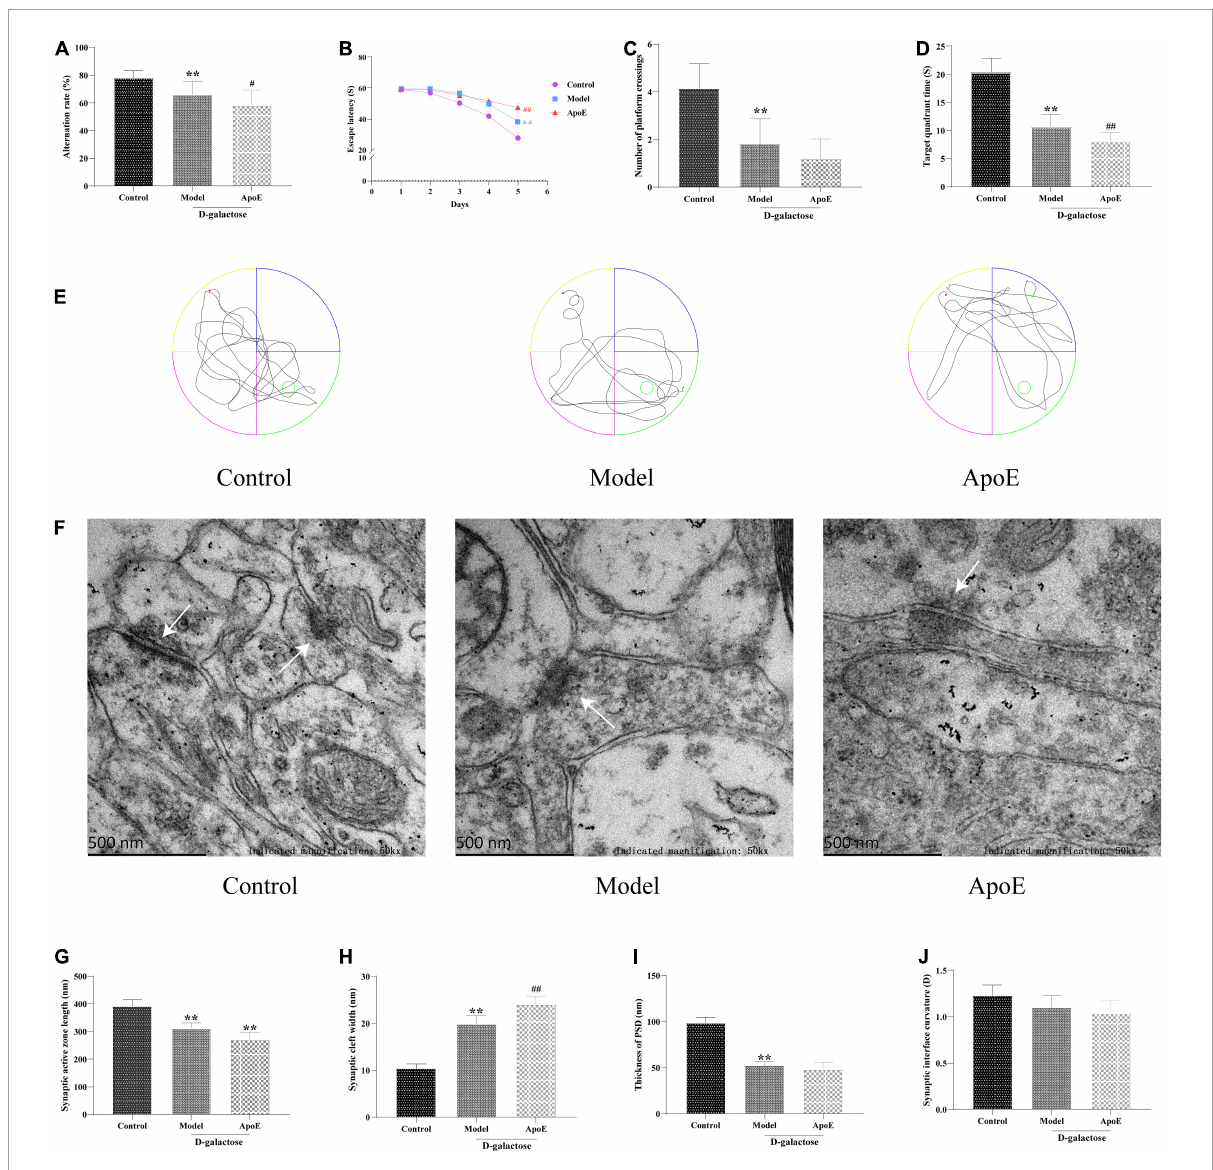
FIGURE2 Effects of ApoE on cognitive function and hippocampal synaptic ultrastructure in aging mice. (A) Y-maze test, n = 20. (B) Navigation test, n = 20. (C) Platform crossing, n = 20. (D) Target quadrant time, n = 20. (E) MWM representative figures. (F) Ultrastructure of hippocampal synapses. (G) Synaptic active zone length, n = 4 (Five synapses were randomly selected from each mouse). (H) Synaptic cleft width, n = 4 (Five synapses were randomly selected from each mouse). (I) Thickness of PSD, n = 4 (Five synapses were randomly selected from each mouse). (J) Synaptic interface curvature, n = 4 (Five synapses were randomly selected from each mouse). ** p < 0.01 vs. Control group, ## p < 0.01, # p < 0.05 vs. Model